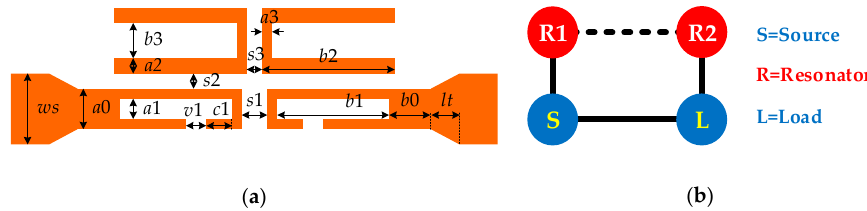
Figure 5. Configuration and coupling scheme of the proposed single-ended bandpass filter: ( a ) Detailed configuration; ( b ) coupling scheme.